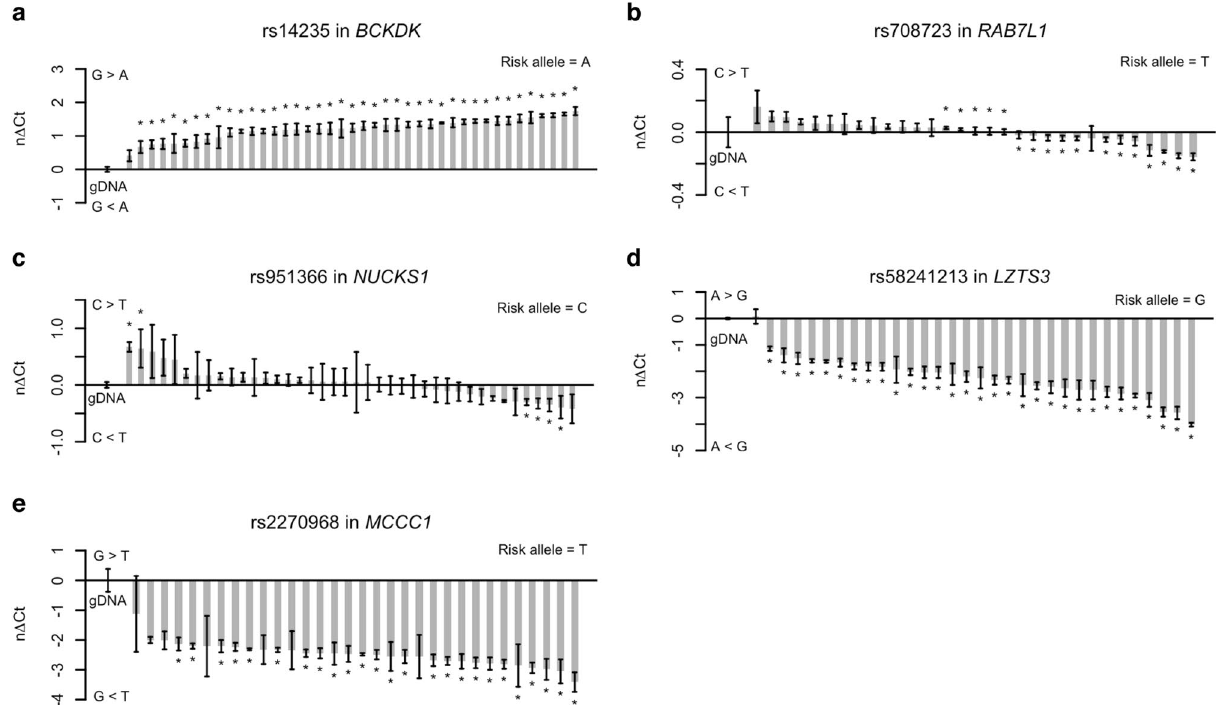
Figure 4. Tissue-specific allelic expression is observed in selected PD-associated risk loci. Allelic expression analysis of ( a ) rs14235 in BCKDK , ( b ) rs708723 in RAB7L1 , ( c ) rs951366 in NUCKS1 , ( d ) rs58231213 in LZTS3 , and ( e ) rs2270968 in MCCC1 was performed in samples from whole blood from PD patients and healthy controls. Heterozygous cDNA samples were measured with five replicates and normalized to the corresponding genomic DNA (gDNA) samples. Columns are presented as the normalized change in Ct between the two alleles (nΔCt). Error bars represent the standard error of the mean. Differences between each sample to the gDNA pool were tested with a Mann–Whitney U test and were considered statistically significant when P ≤ 0.05 as indicated by asterisks. Ct cycle